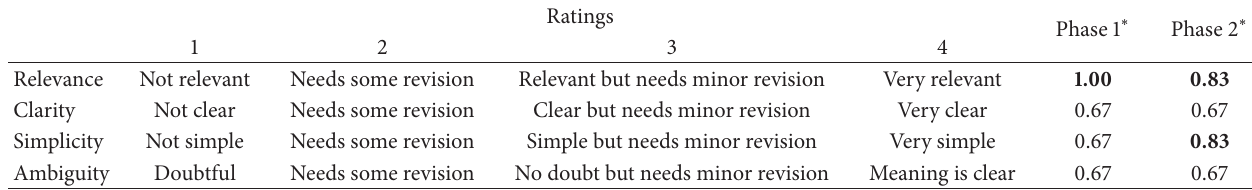
Table 1: Content Validity Index and